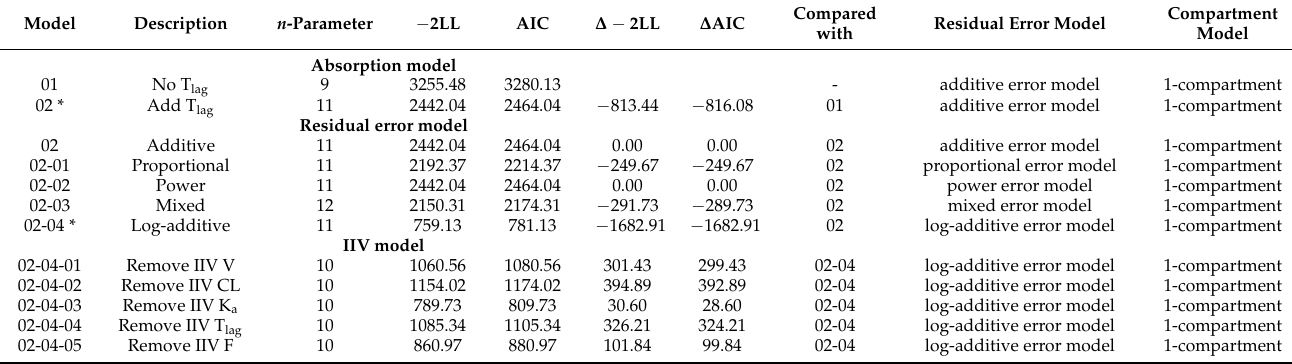
Table 1. Steps used to build the base structural model for free methotrexate solution and methotrexate-loaded nanoformulations. Model